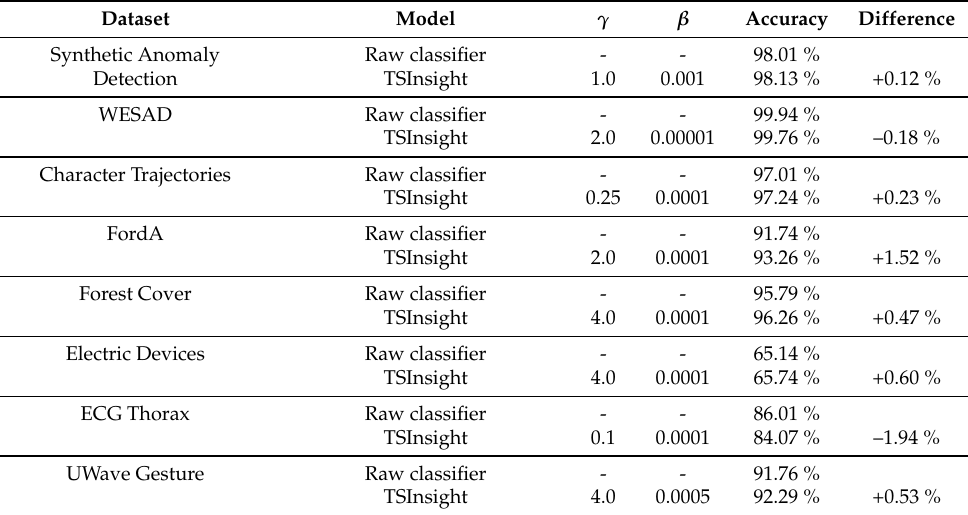
Table 3. Results for the different datasets in terms of accuracy for both the classifier as well as